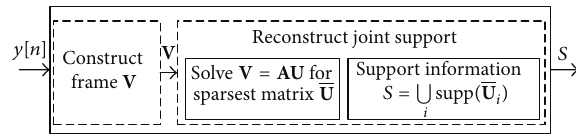
Figure 2: Continuous to finite